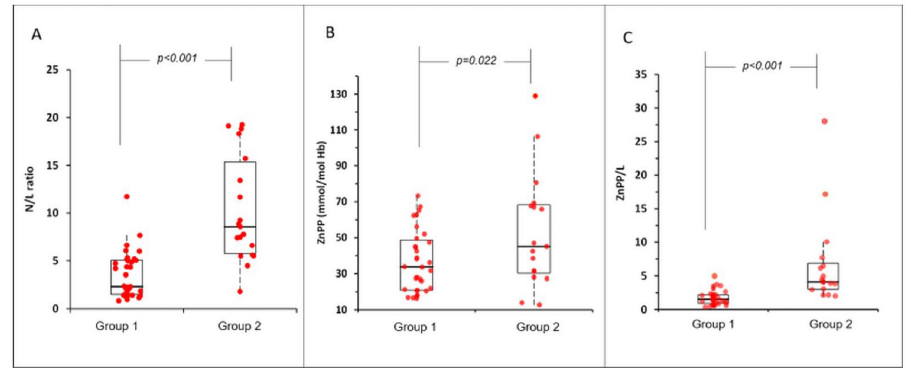
Fig 1. Box plot diagram showing the A. N/L ratio, B. ZnPP (mmol/mol Hb), C. ZnPP/L ratio on COVID-19 severity groups. Group 1: Moderate, Group 2: Severe.